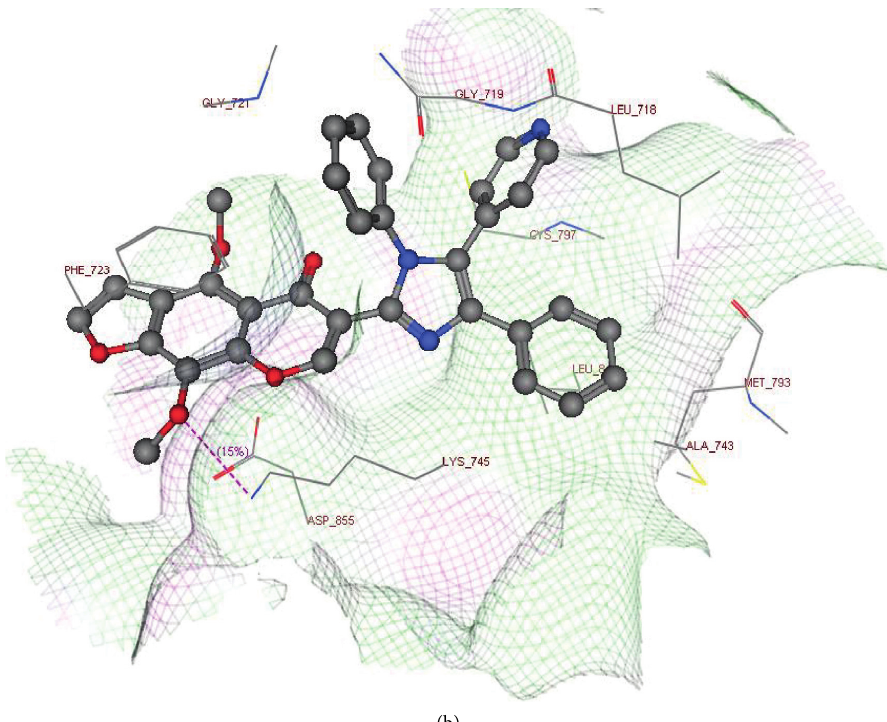
Figure 5: (a) The 2D depiction of the docked conformation of 5e in the EGFR protein (PDB ID: 5CAV) binding site. (b) The 3D depiction of the docked conformation of 5e in the EGFR protein (PDB ID: 5CAV) binding